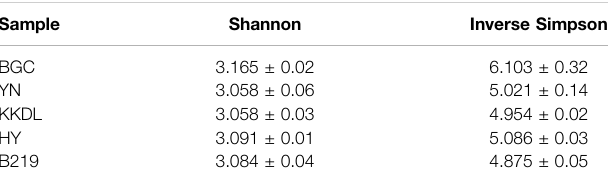
TABLE 3 | Diversity index at genus